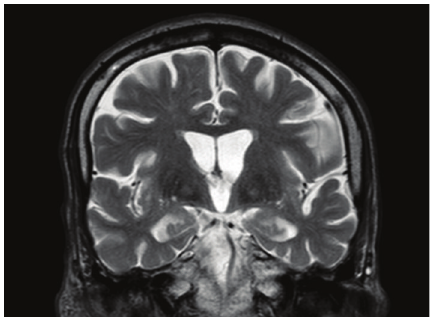
Figure 2: Coronal T2 weighted MRI image showing bilateral “eye of the tiger” sign in globus pallidus as well as bilateral putaminal hypointensity. While there are some areas putaminal T2 hyperintensity, they are not clearly organized into a prominent lateral hyperintense rim and adjacent discrete hypointensity as in